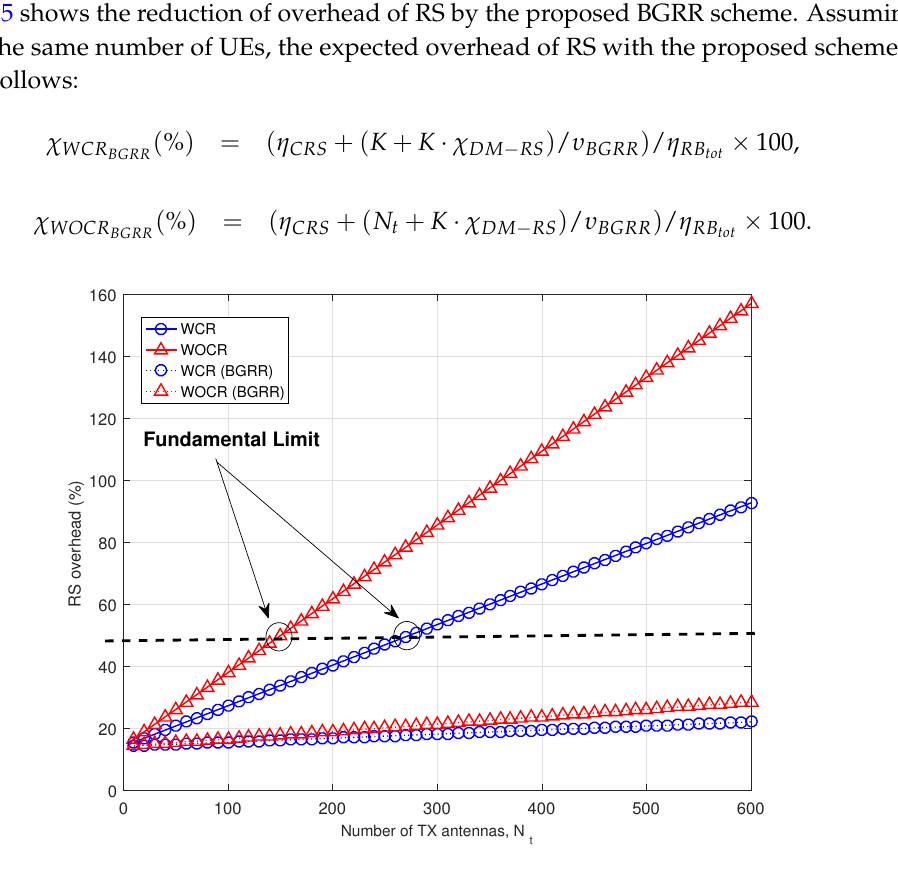
Figure 5. RS overhead (%) versus the number of TX antennas, N t for 5 ms coherence time, υ BGRR =